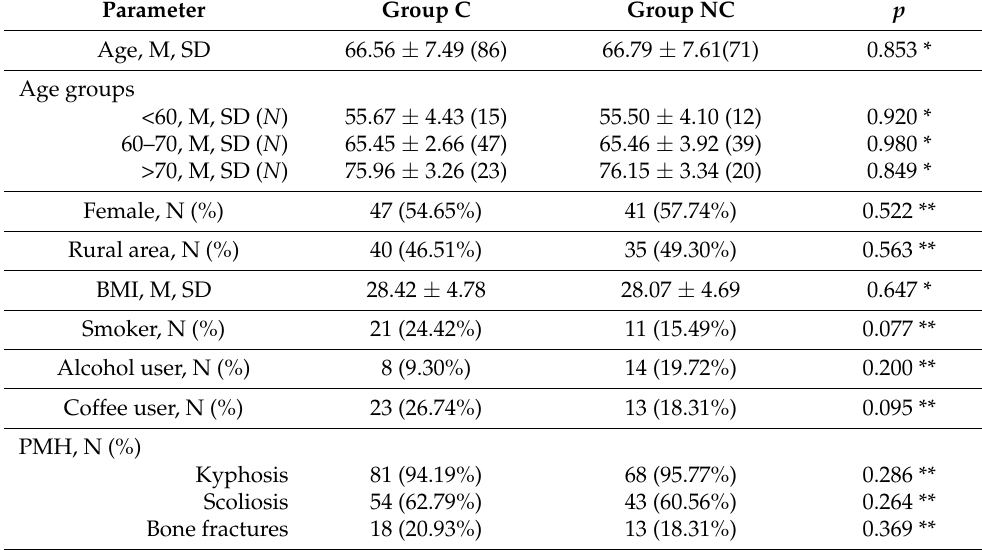
Table 3. Baseline characteristics of the